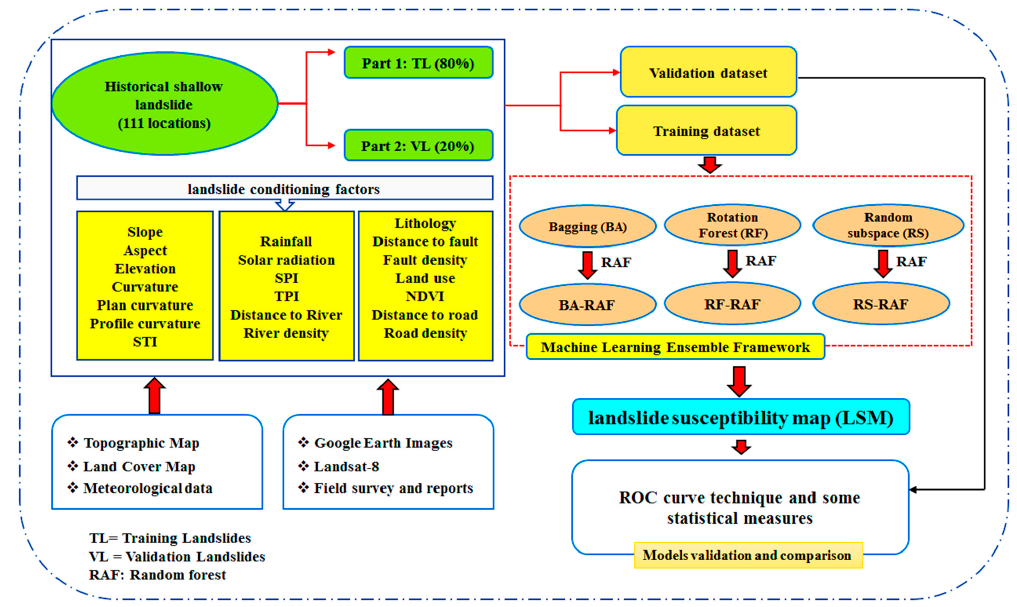
Figure 2. Landslide susceptibility mapping workflow.